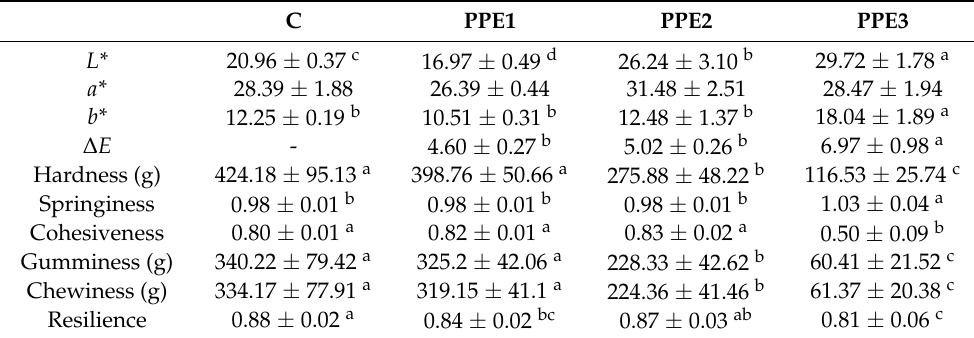
Figure 3. The visual appearances of “Boba balls” with stereomicroscope at 8 × magnification. (C: Control, “Boba balls” without pomegranate peel extract (PPE); PPE1: “Boba balls” containing 1% PPE; PPE2: “Boba balls” containing 2% PPE; PPE3: “Boba balls” containing 3% PPE). Table 2. Color and textural properties of “Boba